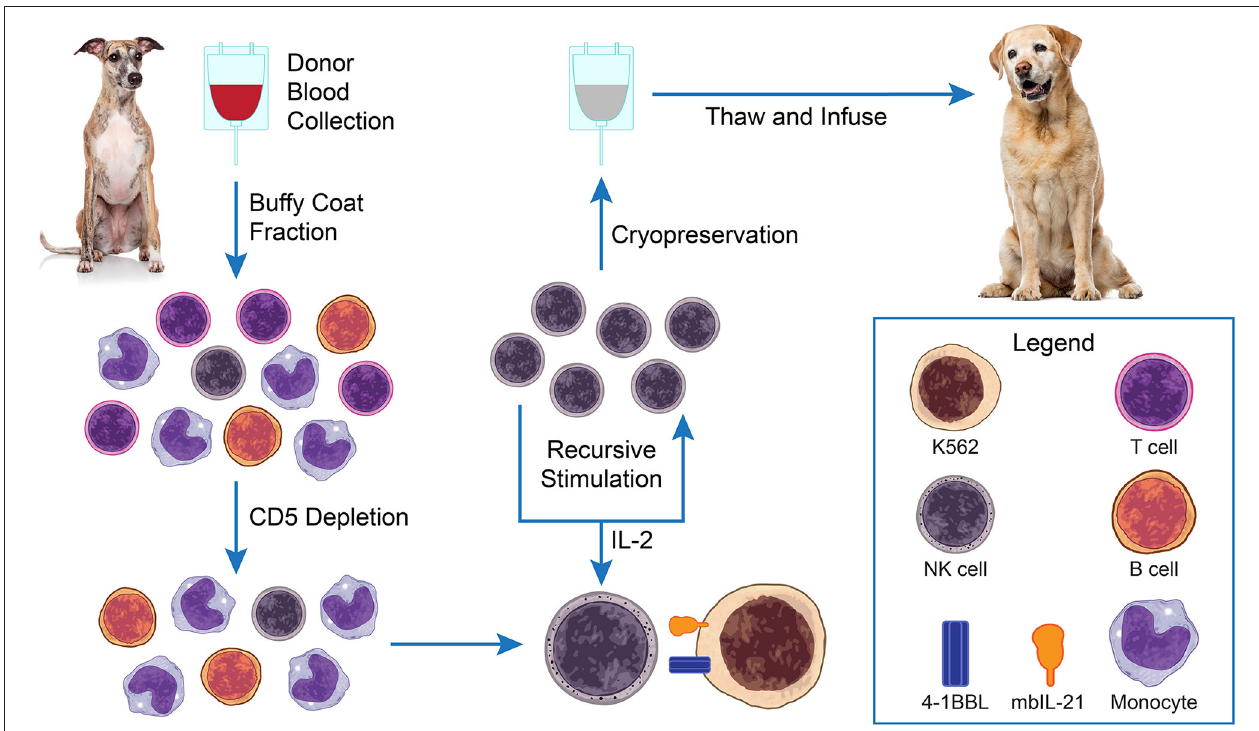
FIGURE 1 | Adoptive natural killer (NK) cell therapy. PBMCs are isolated from blood buffy coats of healthy blood donor dogs by Ficoll separation. The separated cells undergo CD5 cell depletion and are then co-cultured and recursively stimulated in the presence of IL-2 ( ± TGF β ) 3 × over a 3-week period with irradiated K562 feeder cells expressing membrane bound IL-21. Expanded NK cells can be used immediately, or cryopreserved for later